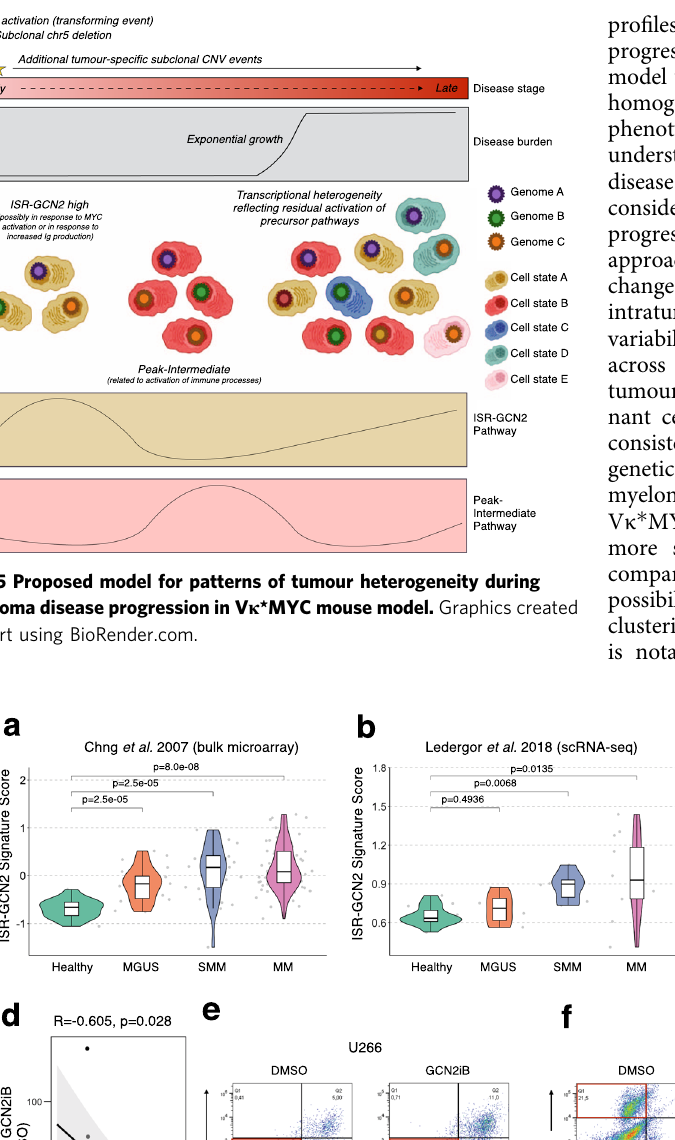
individual data points). Source data are provided in SourceData_Fig. 6.xlsx.